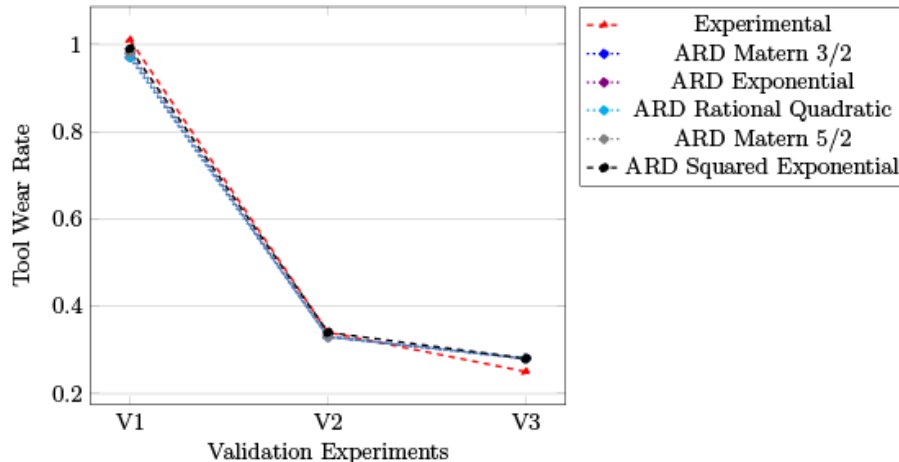
Figure 12. GPR model testing for TWR with different kernels.